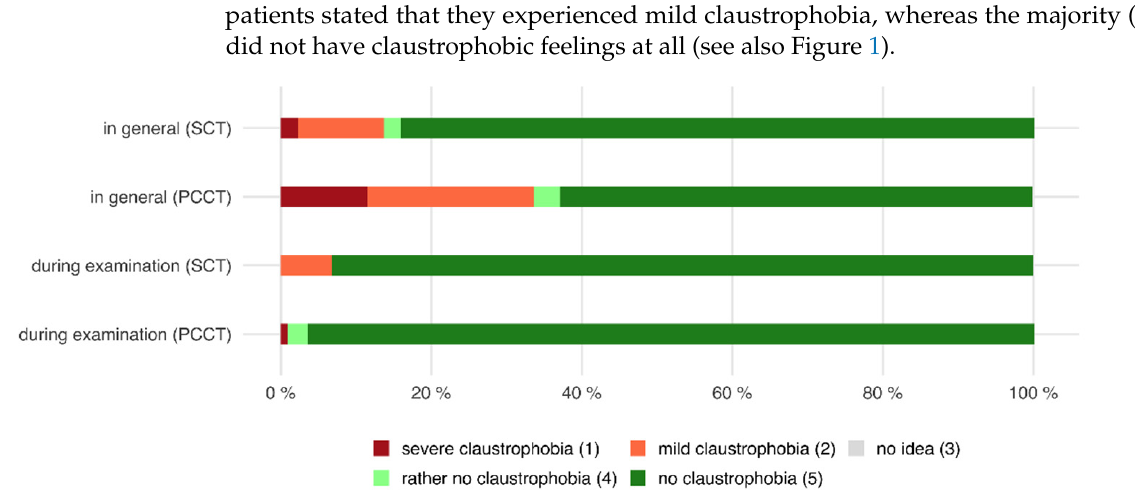
Figure 2. Waffle plot showing the comparison of both CT scanners in terms of claustrophobia where 65.1 % of patients rated the examination with the PCCT as more or markedly more comfort- able compared to an examination SCT.